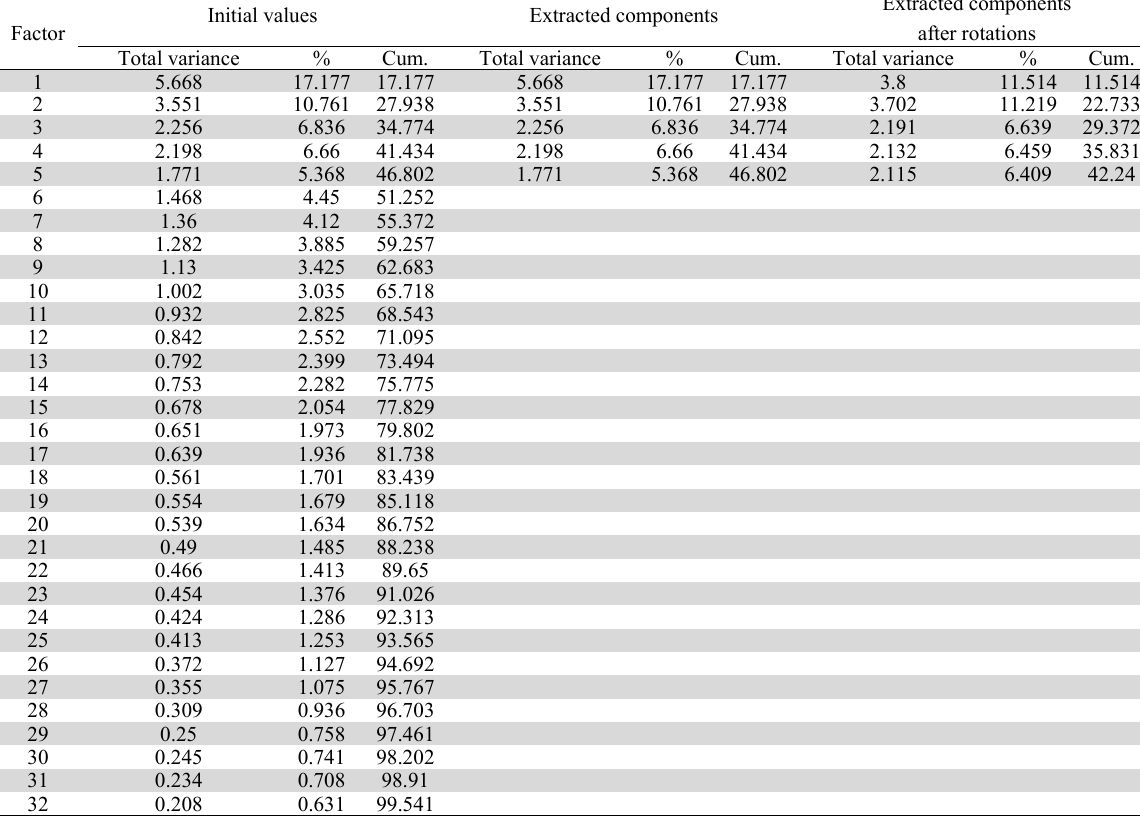
The results of extracted factors using principal component analysis Initial values Extracted components